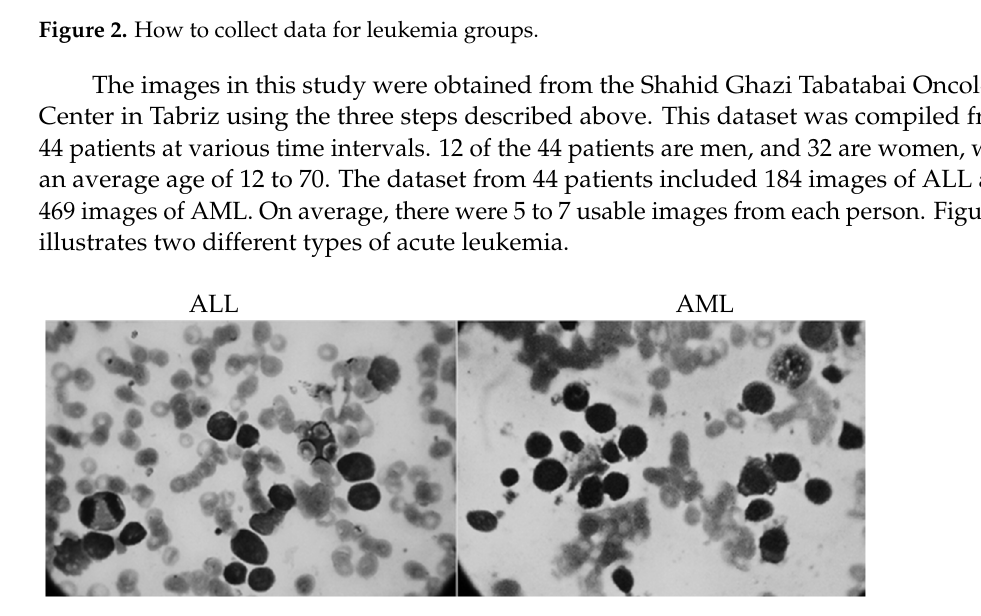
Figure 3. Two different types of acute leukemia.